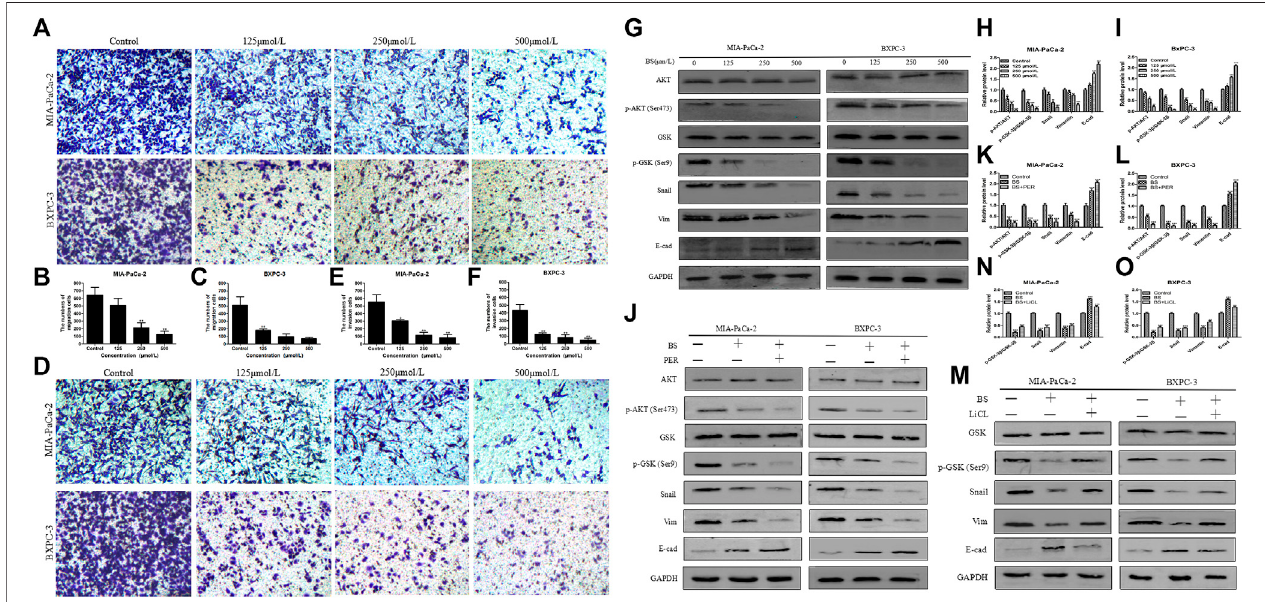
FIGURE 3 | β -Sitosterol (BS) decreases migration and invasion and downregulates the expression of epithelial – mesenchymal transition (EMT) markers and AKT/ GSK-3 β signaling pathways inpancreatic cancercells. (A – C) Fortranswellmigrationassays,MIA-PaCa-2and BXPC-3cells weretreatedwithvariousconcentrationsof BS for 48 h. The number of cells were counted under a microscope (200 × magni fi cation). Quanti fi cation results are showed for migration of MIA-PaCa-2 and BXPC-3 cells.Alldataaredepictedasmean ± SD( n (cid:1) 3;* p < 0.05;** p < 0.01). (D – F) ForMatrigel-coatedinvasionassays,MIA-PaCa-2andBXPC-3cellsweretreatedwith variousconcentrationsofBSfor48 h.Thenumberofcellswerecounted underamicroscope(200 × magni fi cation).Quanti fi cation resultsareshownforinvasionbyMIA- PaCa-2 and BXPC-3 cells. All data are depicted as mean ± SD ( n (cid:1) 3; * p < 0.05; ** p < 0.01). (G – I) MIA-PaCa-2 and BXPC-3 cells were treated with various concentrations of BS for 48 h, and the expression levels of Akt, p-Akt, GSK-3 β , p-GSK-3 β , Snail, vimentin, and E-cadherin were detected by western blotting. The relative protein levels of p-Akt/Akt, p-GSK-3 β /GSK-3 β , Snail, vimentin, and E-cadherin in MIA-PaCa-2 and BXPC-3 cells were shown in the histograms. All data are depictedasmean ± SD( n (cid:1) 3;* p < 0.05;** p < 0.01;*** p < 0.001). (J – L) MIA-PaCa-2andBXPC-3cellsweretreatedwithjustculturemedium,BS(250 μ M/L),orbothBS (250 μ M/L) and PER (10 μ M/L). The expressions of Akt, p-Akt, GSK-3 β , p-GSK-3 β , Snail, vimentin, and E-cadherin in MIA-PaCa-2 and BXPC-3 cells were tested by western blotting, the relative protein levels of p-Akt/Akt, p-GSK-3 β /GSK-3 β , Snail, vimentin, and E-cadherin were shown in the histograms. All data are depicted as mean ± SD( n (cid:1) 3;** p < 0.01;*** P < 0.001). (M – O) MIA-PaCa-2andBXPC-3cellsweretreatedwithjustculturemedium,BS(250 μ M/L),orbothBS(250 μ M/L)andLiCL (20 mM/L).TheexpressionsofGSK-3 β ,p-GSK-3 β ,Snail,vimentin,andE-cadherininMIA-PaCa-2andBXPC-3cellsweretestedbywesternblotting,therelativeprotein levels of p-GSK-3 β /GSK-3 β , Snail, vimentin, and E-cadherin were shown in the histograms. All data are depicted as mean ± SD ( n (cid:1) 3; ** p < 0.01; *** p < 0.001).